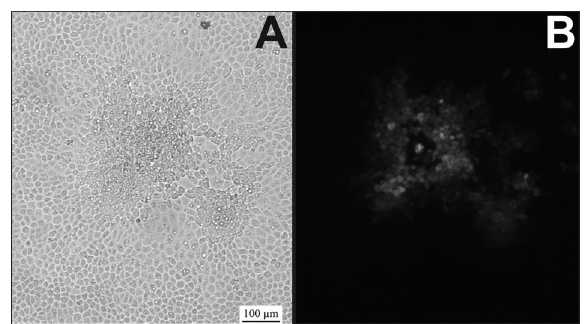
Figure 2. Identi fi cation of a recombinant virus expressing the GFP selection marker. Plaques formed in MDBK cell monolayers were visualized under light microscopy ( A ) and UV light ( B ).